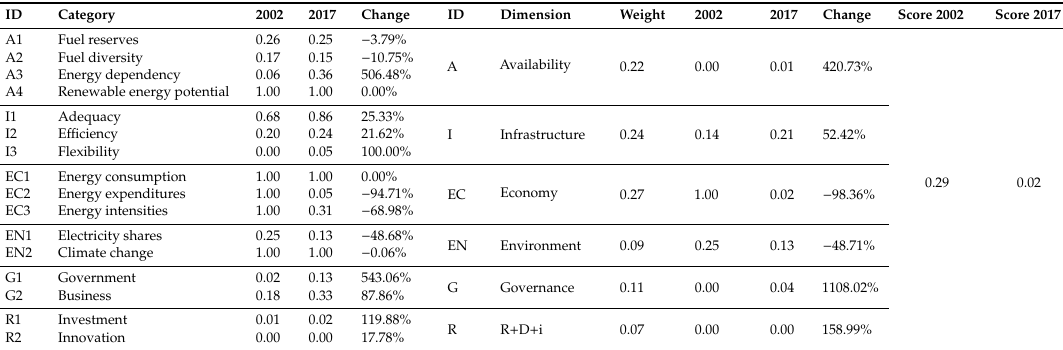
Table 3. PSIx score in the Argentinian